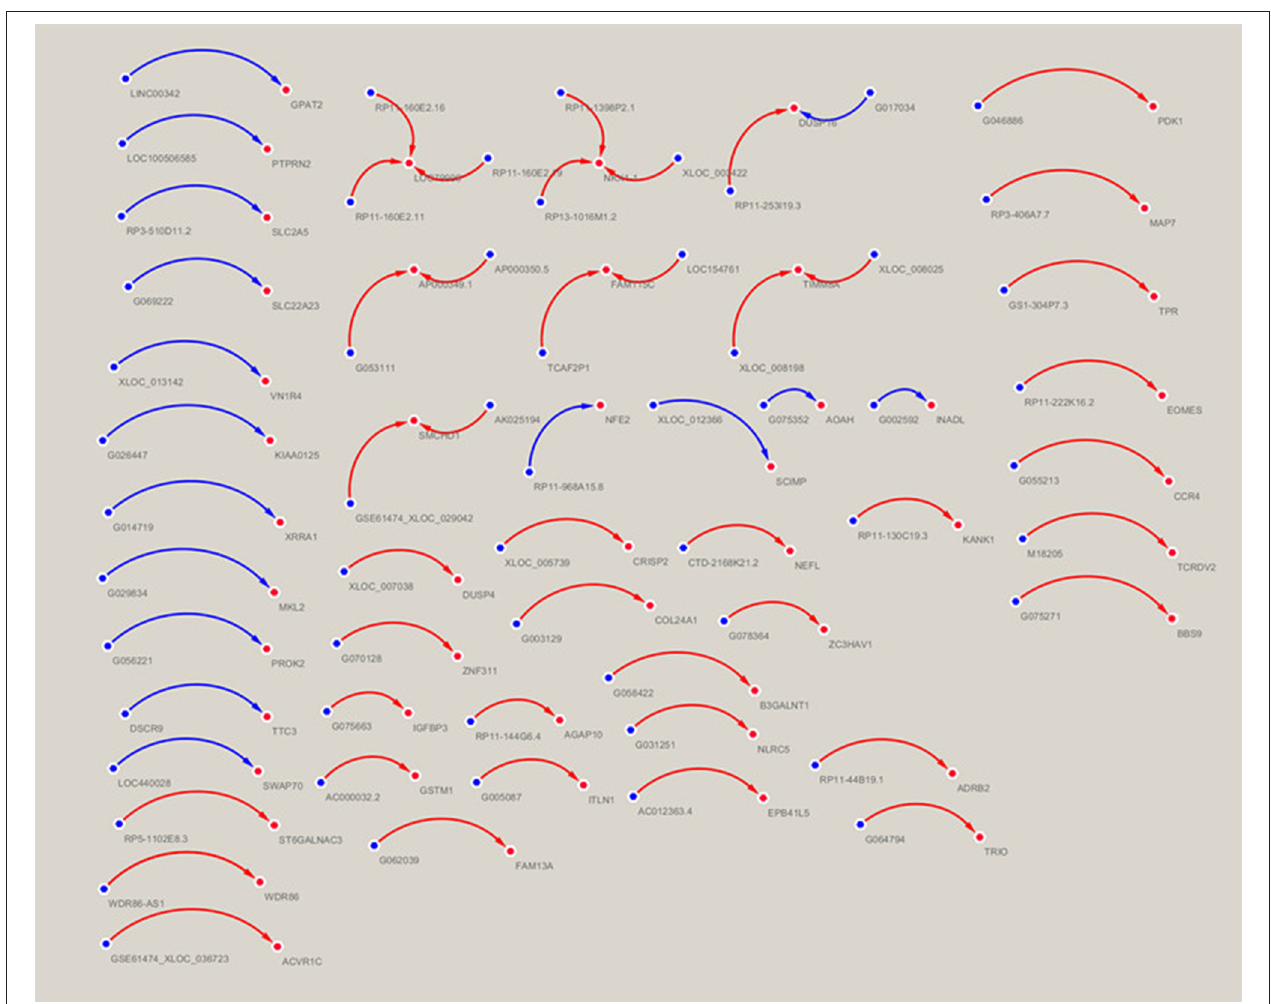
FIGURE 6 | Correlation analysis between the lncRNAs and mRNAs. In the network analysis, the blue node represents the lncRNA, and the red node represents the mRNA. The blue lines indicate a negative correlation, and the red lines indicate a positive correlation.